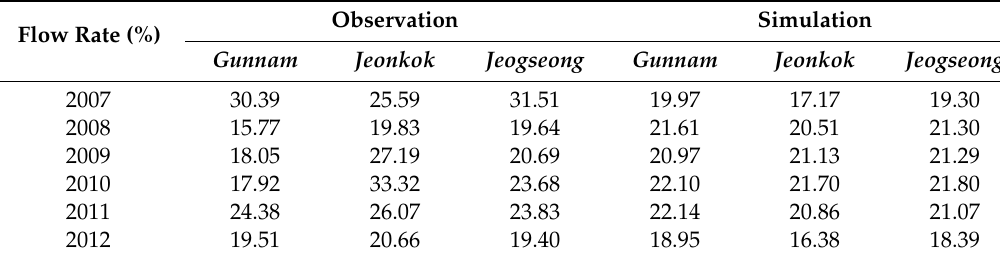
Table 1. Flow rate (%) of 6 flood seasons from 2007 to